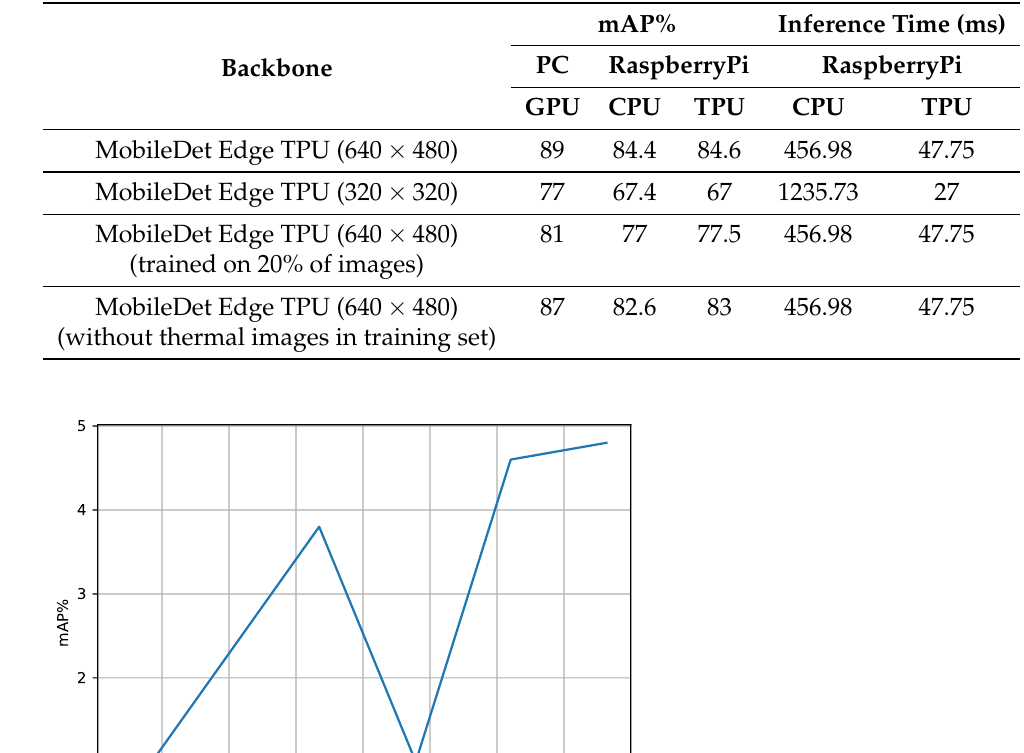
Table 3. Performance of the SSD MobileDet under different parameters.